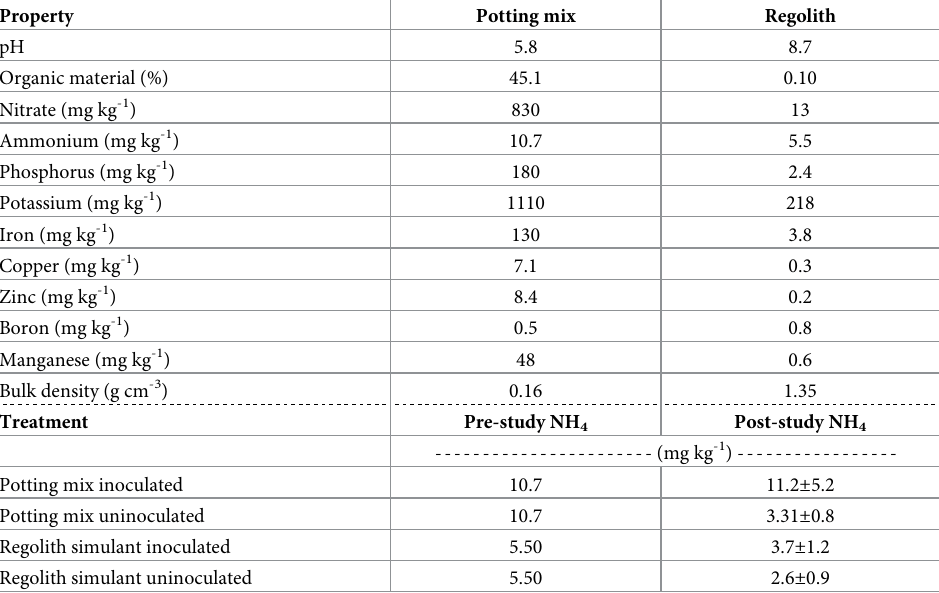
Table 1. Initial potting mix and regolith properties, and NH 4 concentrations pre- and post-study.